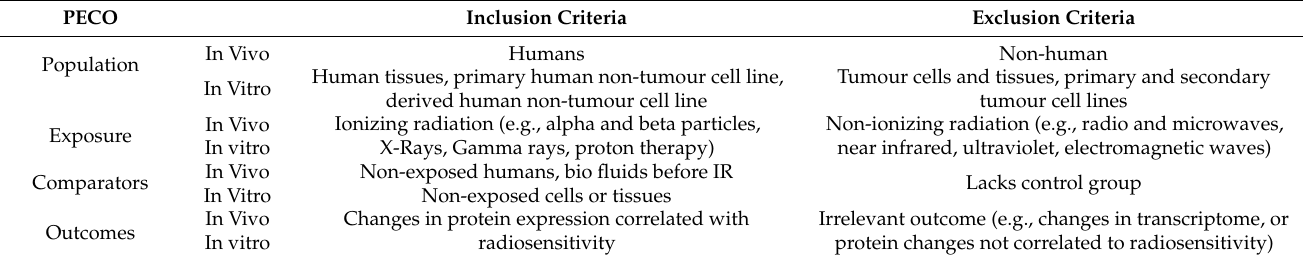
Tumour cells and tissues, primary and secondary tumour cell lines Non-ionizing radiation (e.g., radio and microwaves, near infrared, ultraviolet, electromagnetic waves)In vitro Lacks control group